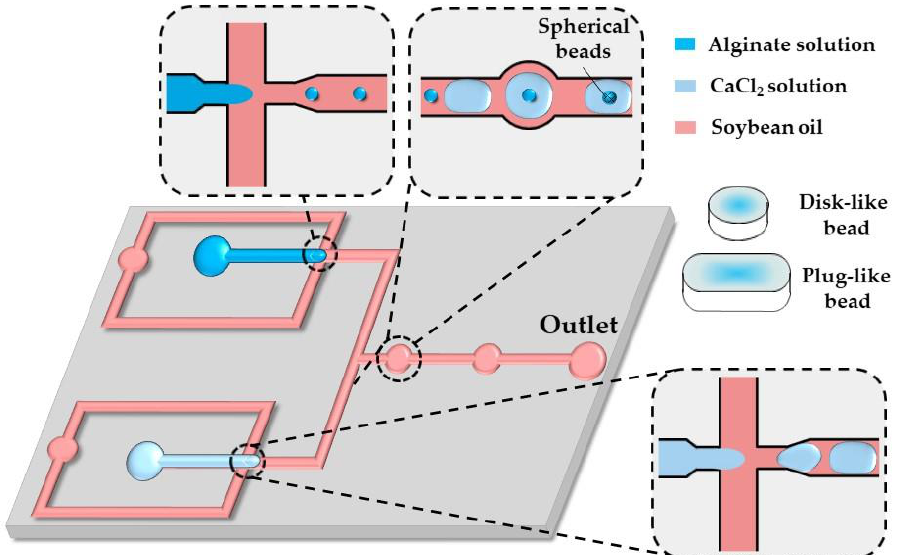
Figure 15. Formation of disk-like, plug-like, and spherical alginate beads in the chip consisting of two flow-focusing junctions for alternating the generation of alginate and CaCl 2 droplets and a fusion channel with two circular expansion chambers for droplet merging. The droplet shape is modified by their confinement in one direction (disks) or two directions (plugs) [65].